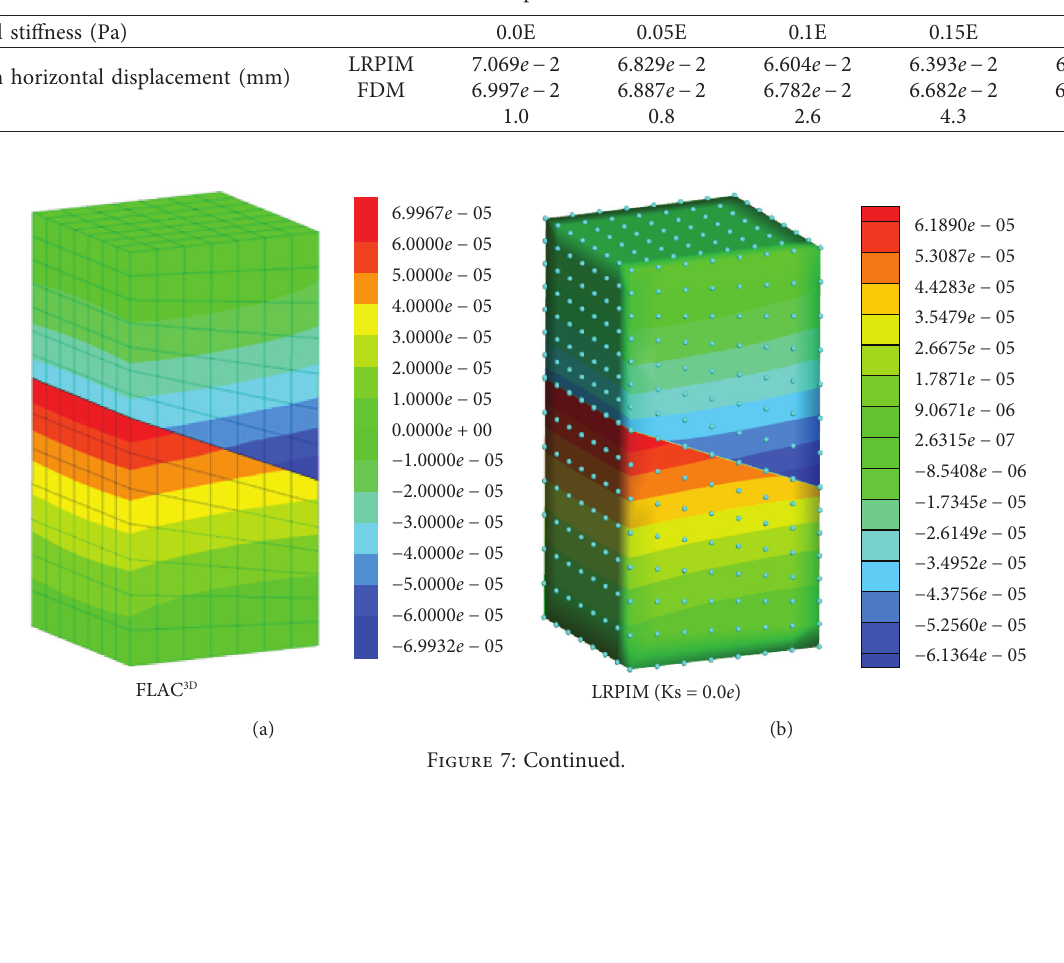
Figure 6: Schematic diagram of oblique through Table 1: Horizontal displacement of the model.